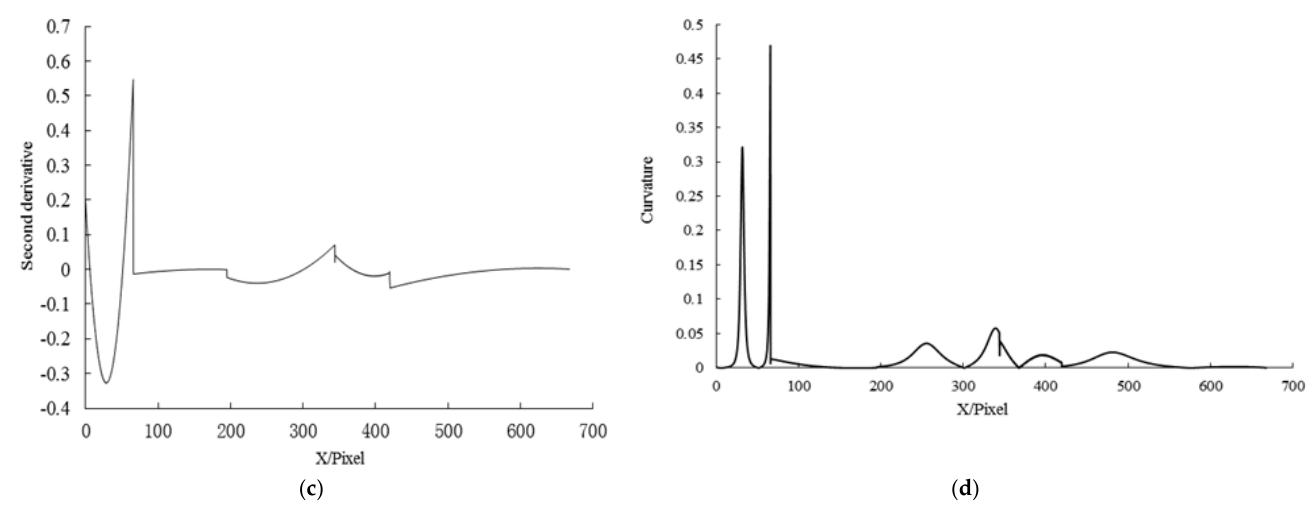
Figure 2. Fitted curve of upper jaw and its residual value: ( a ) fitted curve; ( b ) residuals; ( c ) second derivative; and ( d ) curvature.